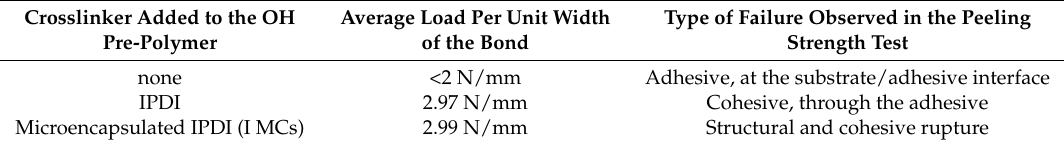
Figure 13. Peeling strength tests result. Load versus propagation extension for adhesive joints with IPDI and microencapsulated IPDI (I MCs), as crosslinkers. Table 4. Peeling strength tests’ results.